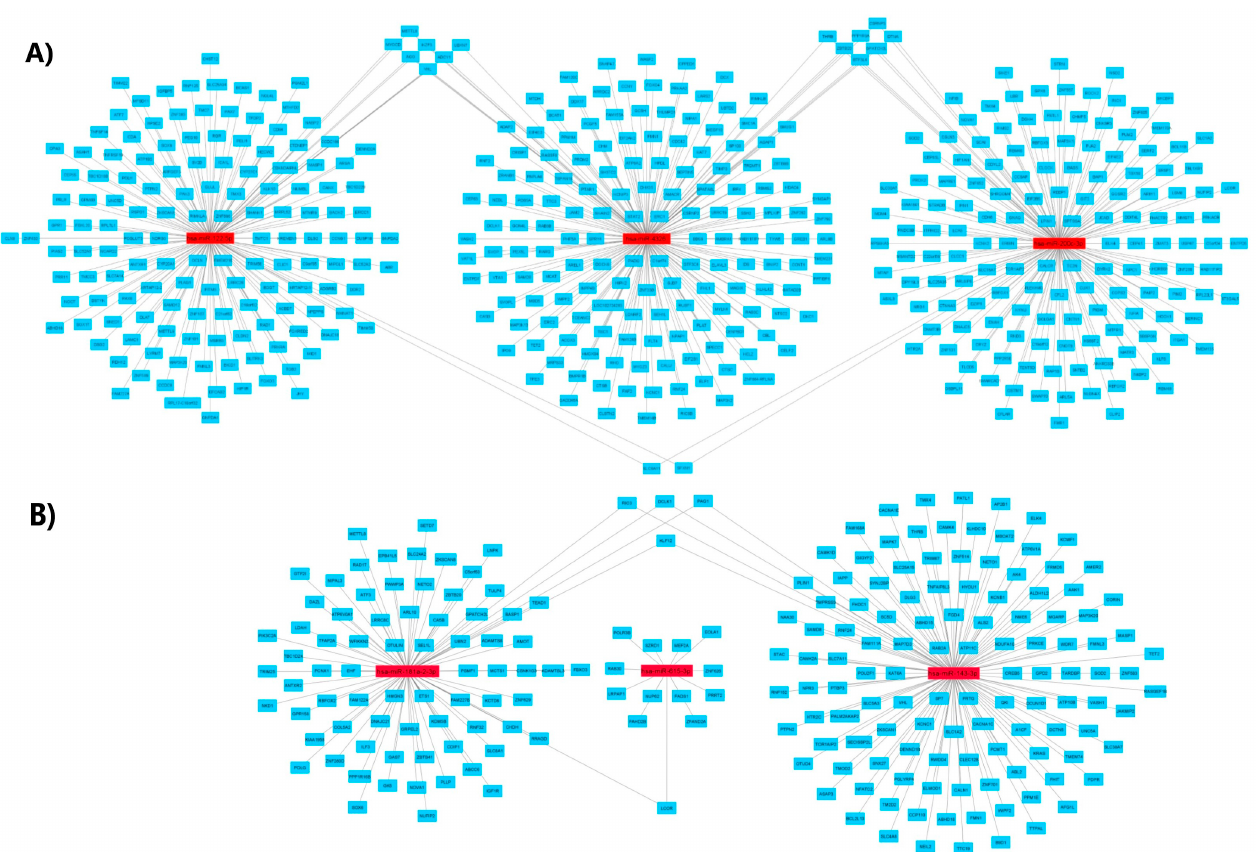
Figure 5. Interaction networks of upregulated and downregulated miRNA target genes. ( A ) upregu- lated miRNAs, ( B ) downregulated miRNAs. Cytoscape program was used to create the interaction network, using miRDB as a database and miRWalk website for